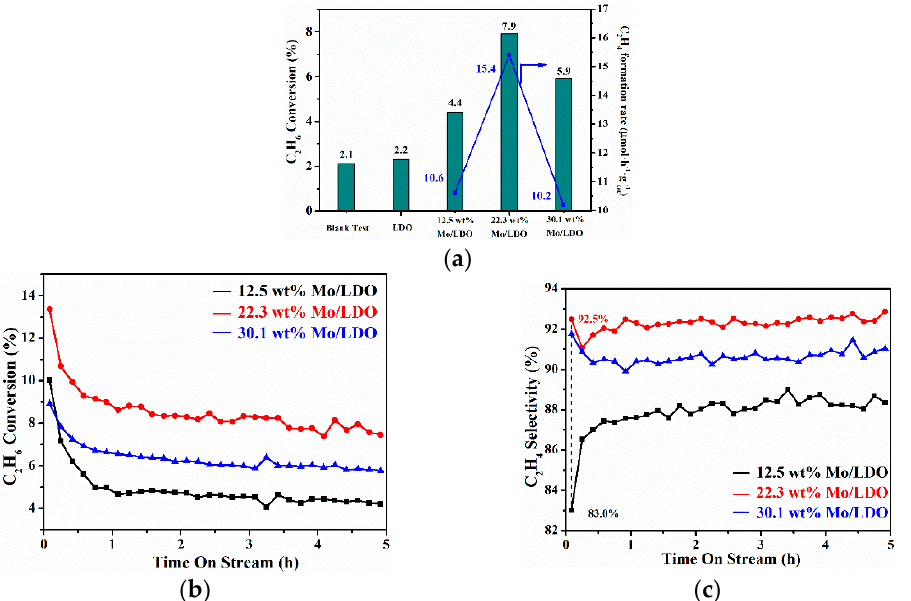
Figure 10. ( a ) Ethane conversion in the stable stage and the initial ethylene formation rate; ( b ) C 2 H 6 conversion and ( c ) C 2 H 4 selectivity as functions of the time on stream over Mo/LDO catalysts. Reaction conditions: T = 873 K, C 2 H 6 /CO 2 /N 2 = 1: 1: 2, the total flow rate = 60 mL min − 1 . Table 3. The detail of catalytic performance over the Mo/LDO